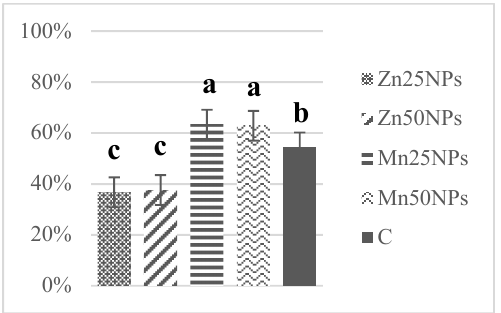
Figure 6. Percentage of turkey sperm with functional mitochondria (%) in samples stored for 48 h